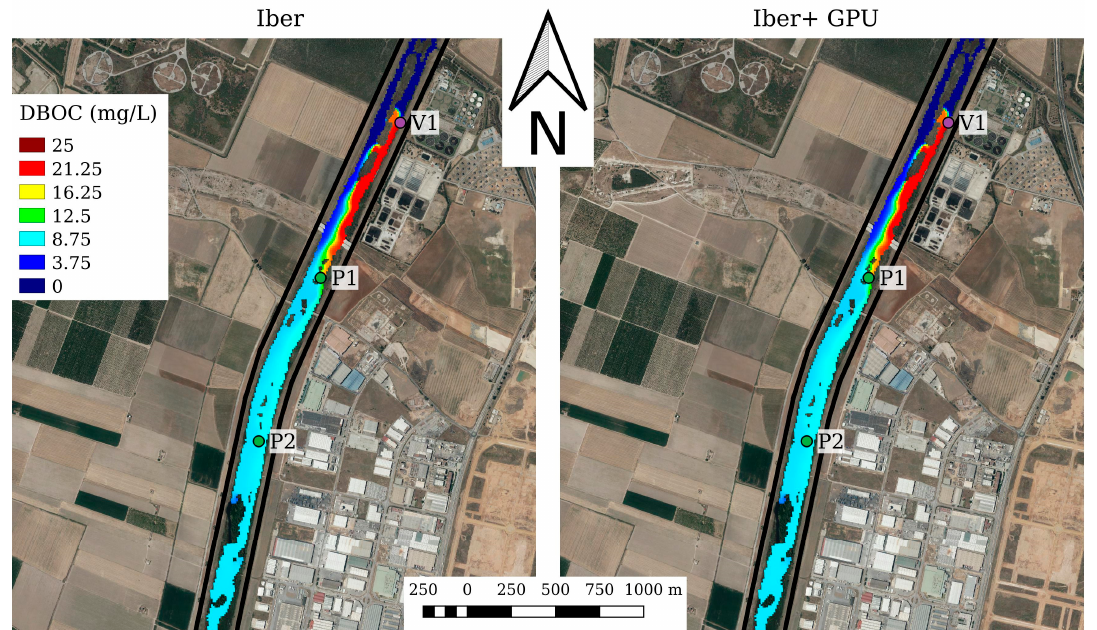
Figure 12. Detail of the concentration of CBOD downstream the sewage spill at t = 60 h using both Iber and Iber+ implementations.